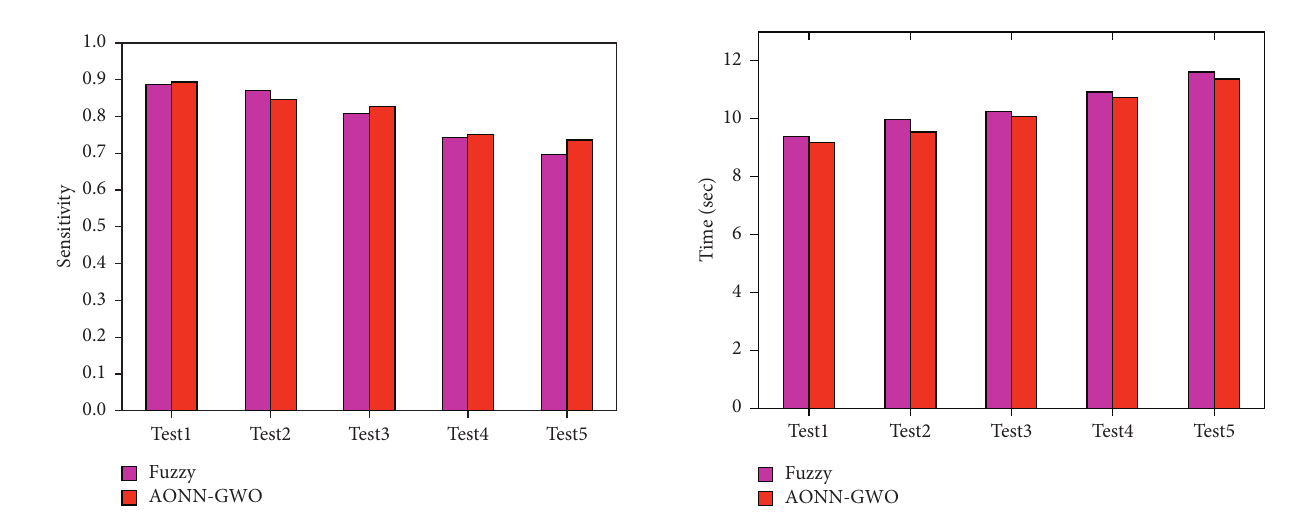
Figure 5: Comparative analysis of sensitivity result.